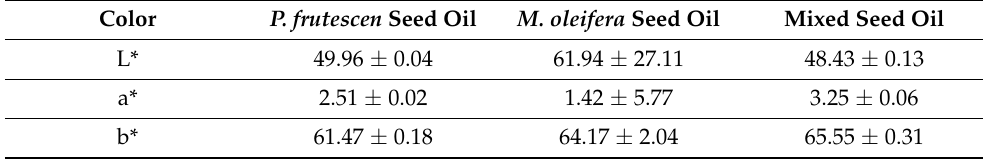
Table 3. Results of color analysis of P. frutescens, M. oleifera , and mixed seed